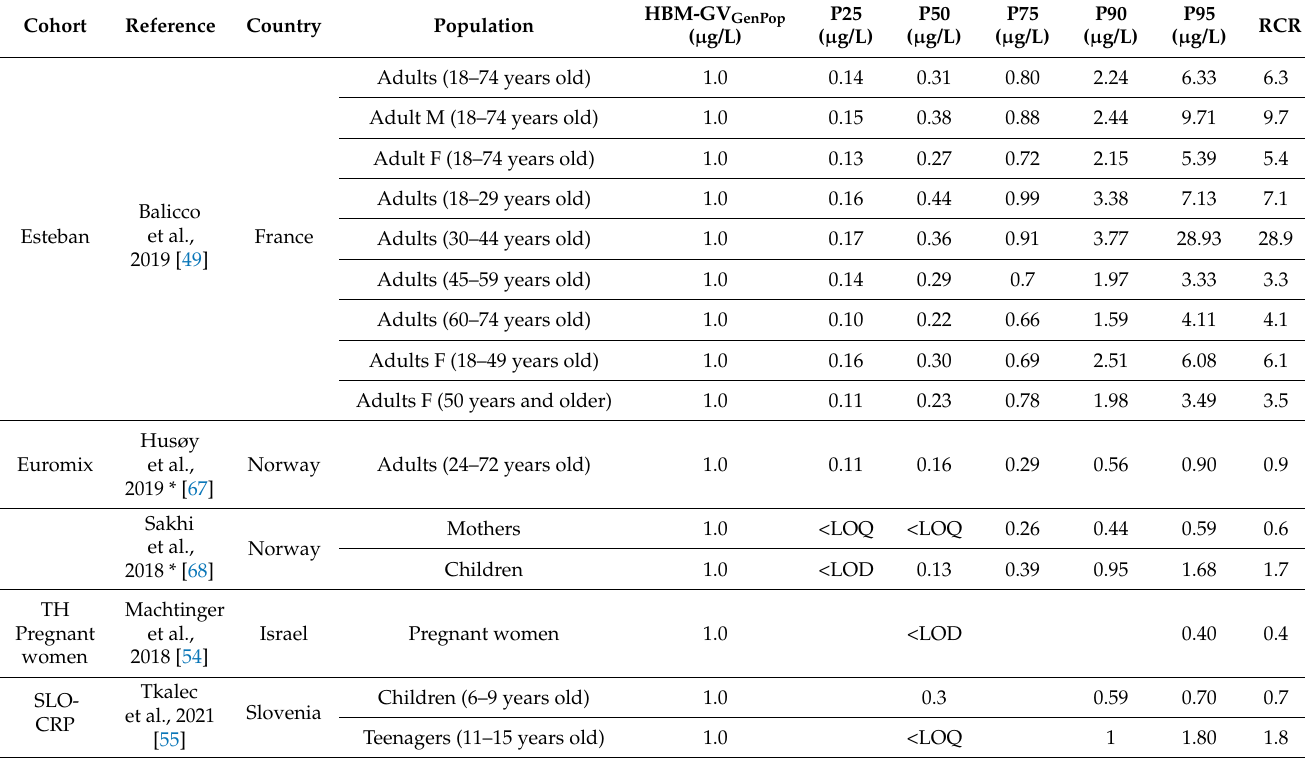
Table 4. Summary of HBM data and calculated RCRs for total urinary BPS for the general population.